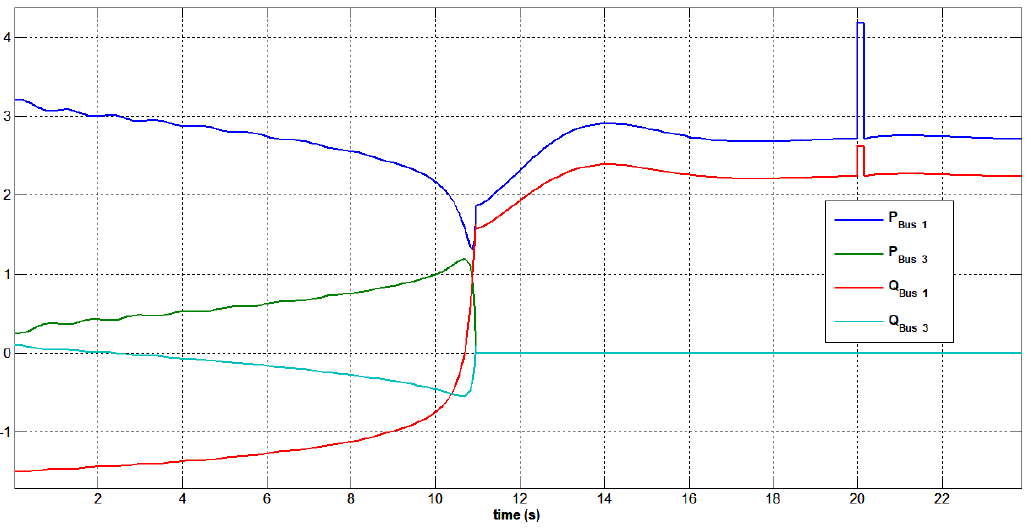
Figure 37. Generated active and reactive power at buses 1 and 3 under three-phase short circuit bus 15.